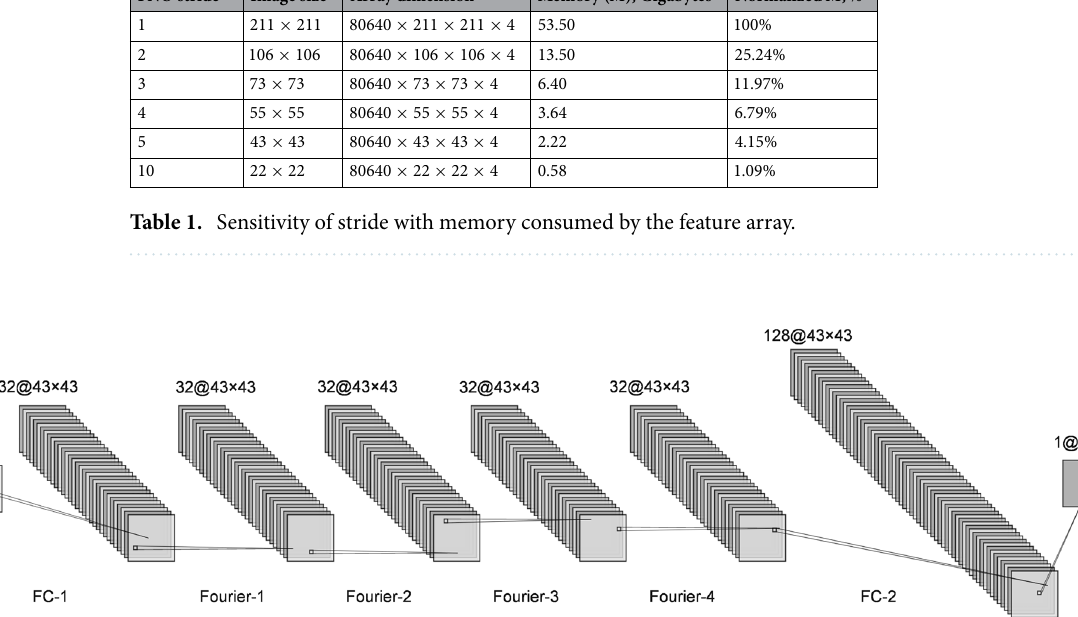
Figure 2. Architecture of Fourier Neural Operator with 3 fully connected (FC) and 4 Fourier layers. α @ n x × n y at the top of each layer denotes: a - number of features; n x - the image width; n y - the image